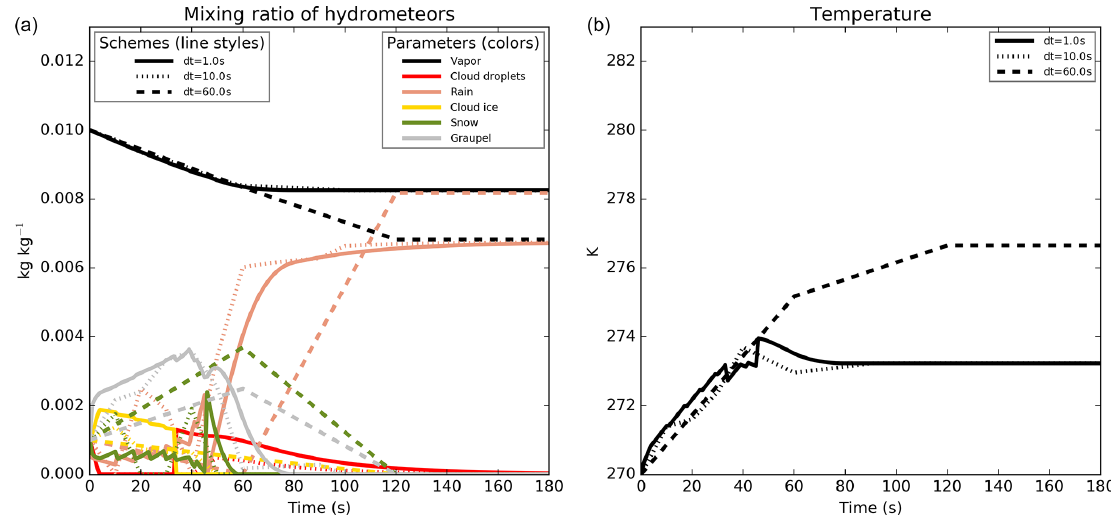
Figure 1. Time evolution of the mixing ratio of the different hydrometeors (in kgkg − 1 , a ) and of the temperature (in K; b ). The simulations were performed using time steps between 1 and 60s.